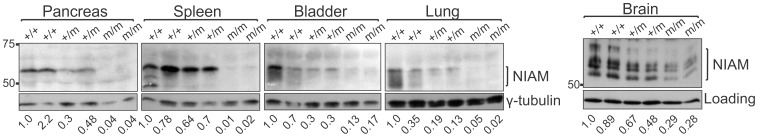
NIAM protein expression in tissues of NIAM mutant mice.NIAM protein levels were assessed in mouse tissues from two mice of each genotype (+/+, +/m, m/m). Equivalent amounts of protein lysates from spleen, bladder, lung, brain, and pancreas were analyzed by immunoblotting with antibodies to NIAM and γ-tubulin. The relative expression of NIAM in each sample, as compared to the first wild-type (+/+) sample in each tissue set, is denoted below the lanes. Relative NIAM levels were determined by Image J analysis of band intensities followed by normalization of those values to quantified intensities of the loading control (γ-tubulin or the non-specific band in brain lysates) in each sample.